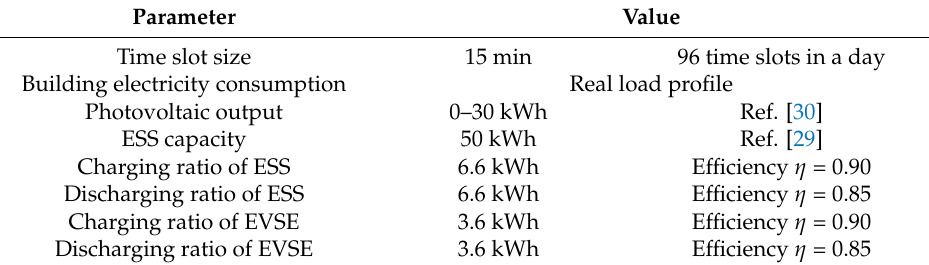
Table 3. Simulation parameters and assumption; EVSE: electric vehicle supply equipment.